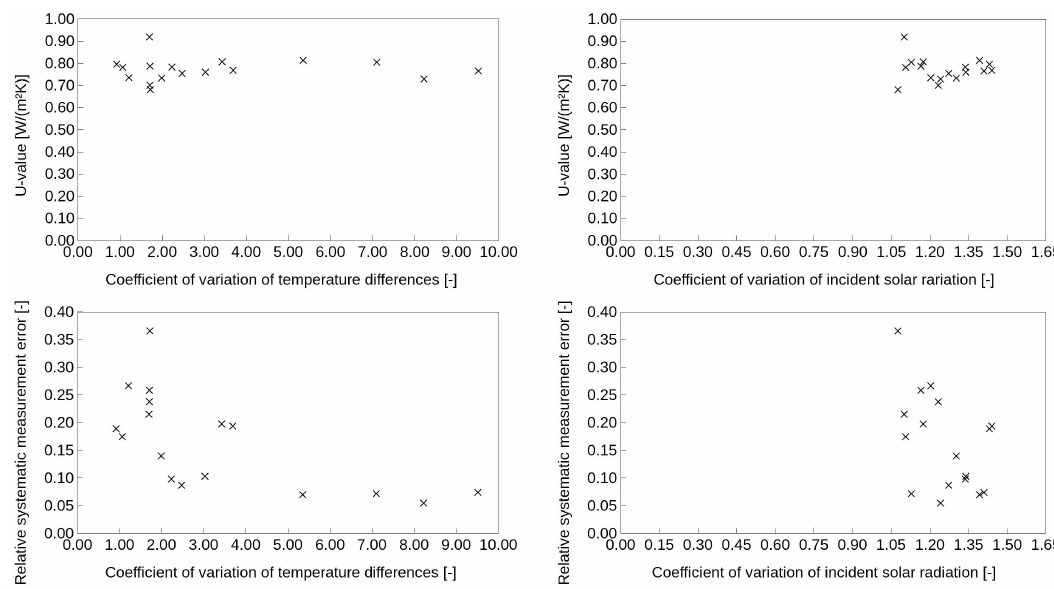
Figure 12. U -value and relative systematic measurement error estimates for the 2TM model as a function of the coefficient of variation of both the temperature differences ( top ) and the incident solar radiation ( bottom ) for the